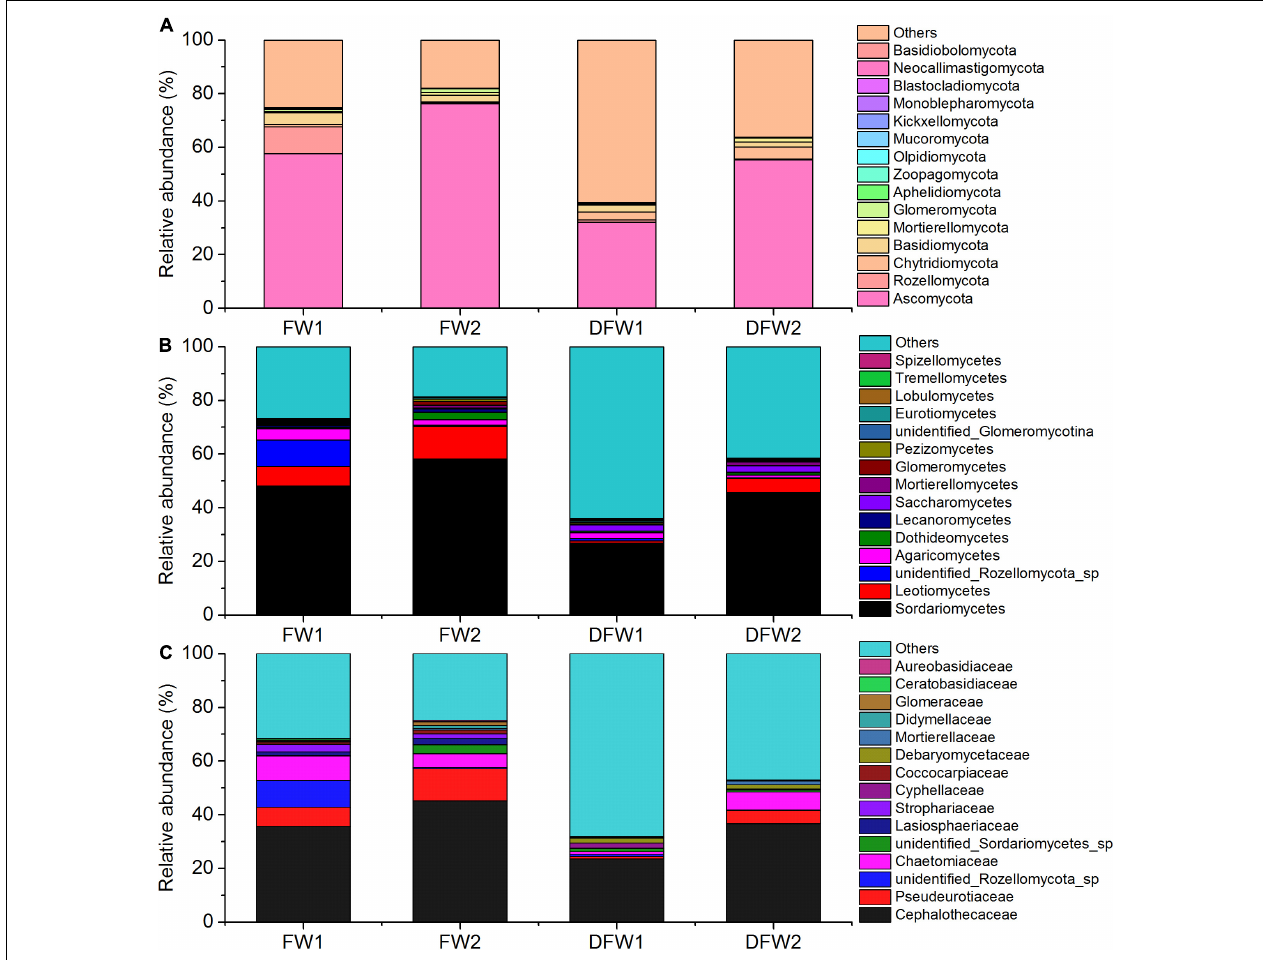
FIGURE 2 | The fungal community structure in 0–5 and 5–10 cm soils of FW and DFW at phylum level (A) , at class level (B) , and at family level (C) . (Note: 1 represents 0–5 cm soils and 2 represents 5–10 cm